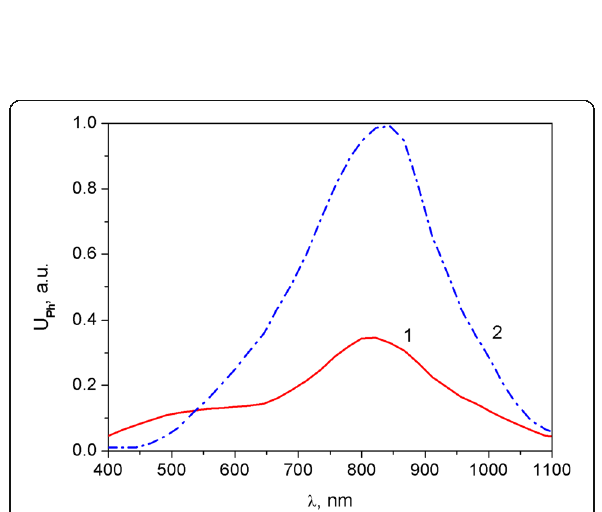
Fig. 5 Photovoltage spectra for the RGO – PS structure (curve 1 ) and industrial silicon photodiode (curve 2